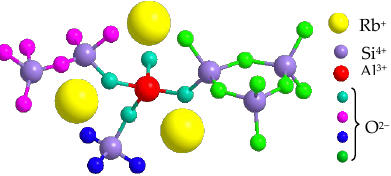
Figure 20. The schematic diagram of Rb 2 O polymerize the slag network.